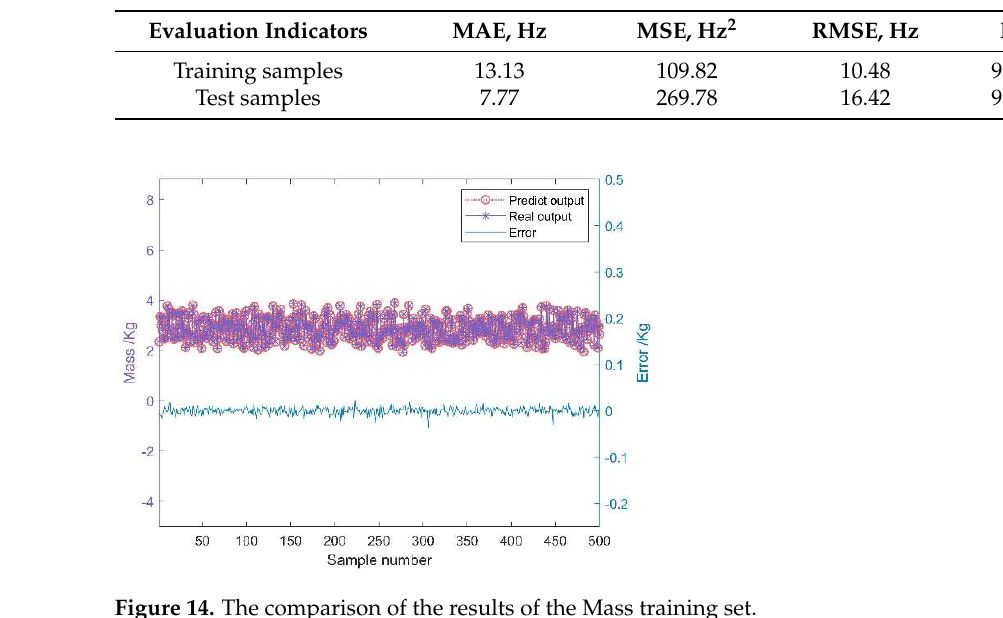
Figure 14. The comparison of the results of the Mass training set.